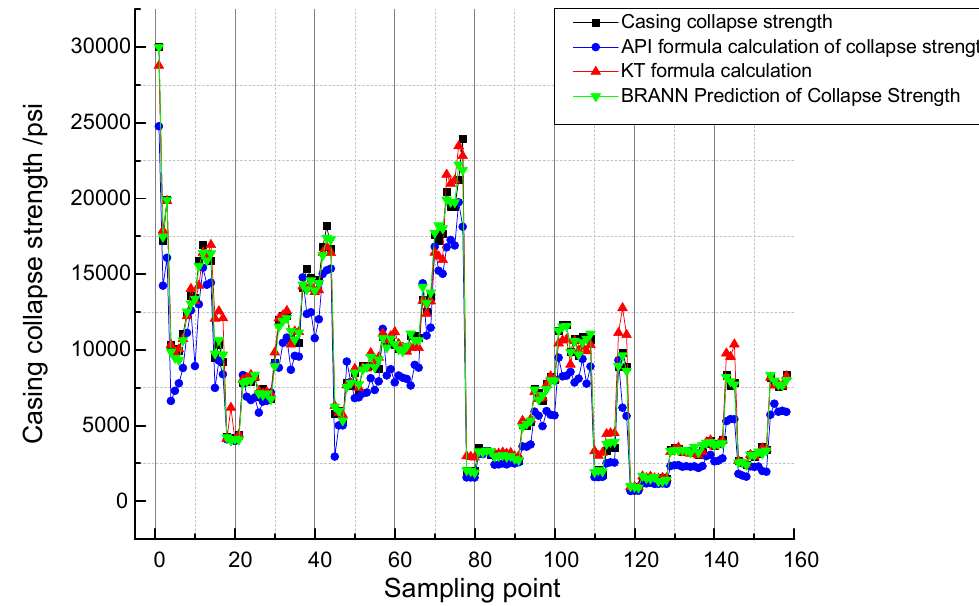
Figure 10. Prediction result of casing collapse strength.